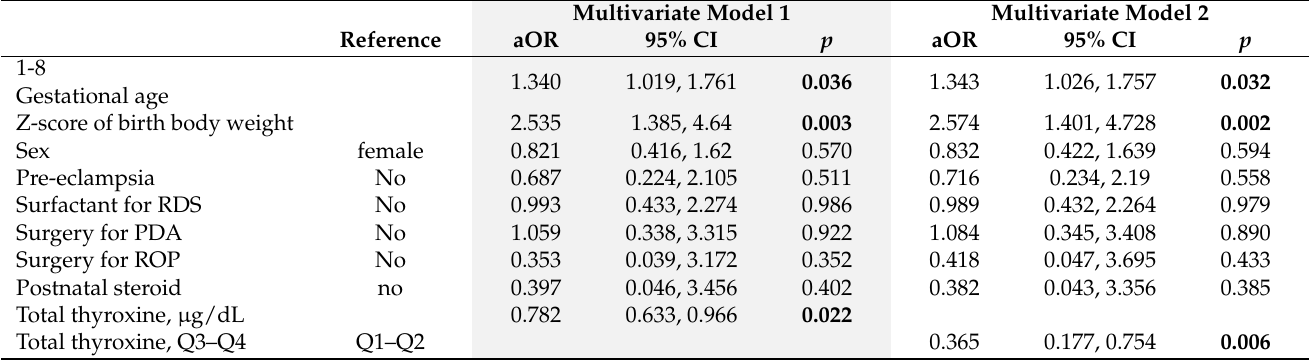
Table 5. Association between thyroxine level and overweight status at the corrected age of 24